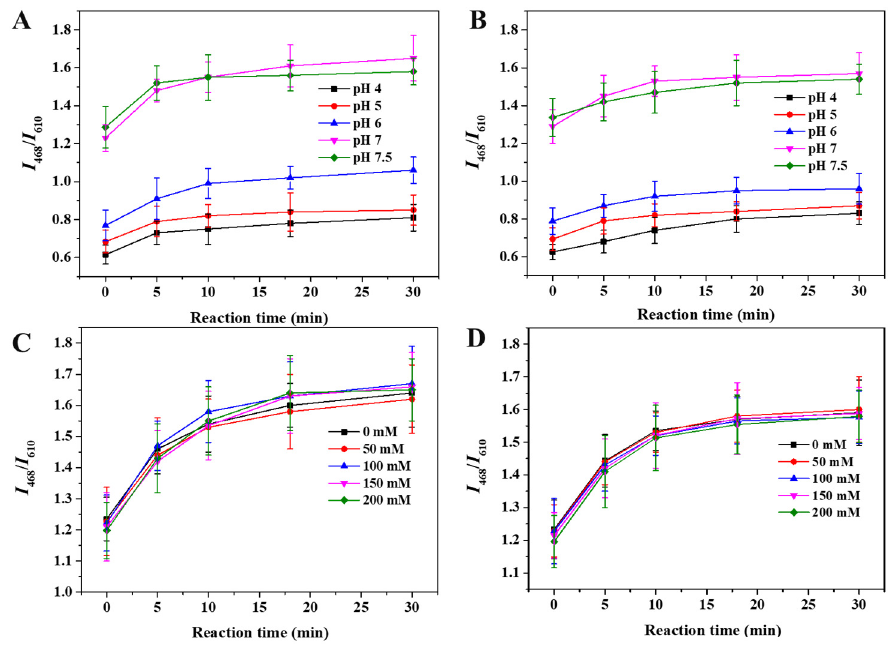
Figure 4. The changes of I 468 / I 610 of SiQD-AgNC reacting with ( A ) H 2 S and ( B ) CH 3 SH under di ff er- ent pH. The changes of I 468 / I 610 of SiQD-AgNC reacting with ( C ) H 2 S and ( D ) CH 3 SH under di ff er- ent ion strength.